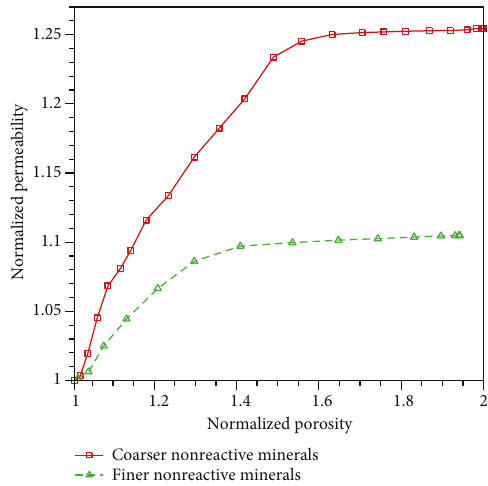
Figure 7: Normalized permeability versus normalized porosity at Pe =26 and Da=20 for initially mixed mineral assemblage where two di ff erent mineral sizes are used for nonreactive